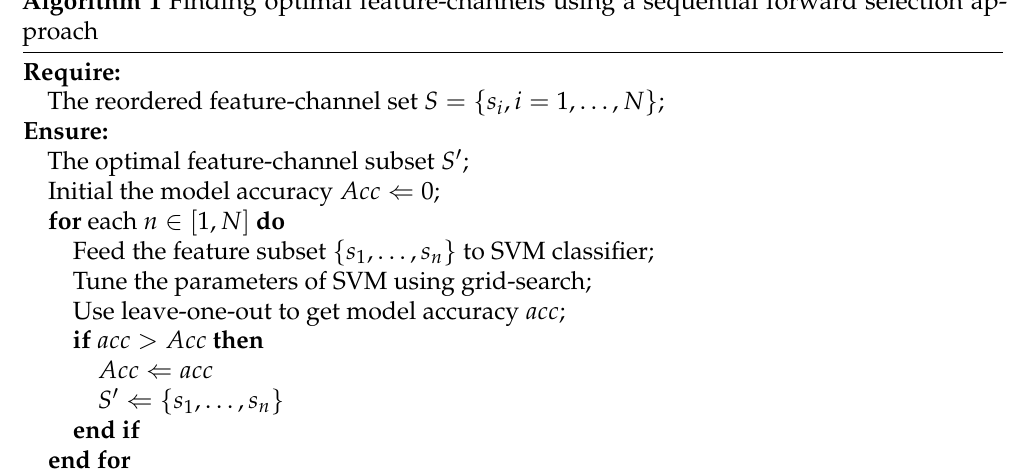
Algorithm 1 Finding optimal feature-channels using a sequential forward selection